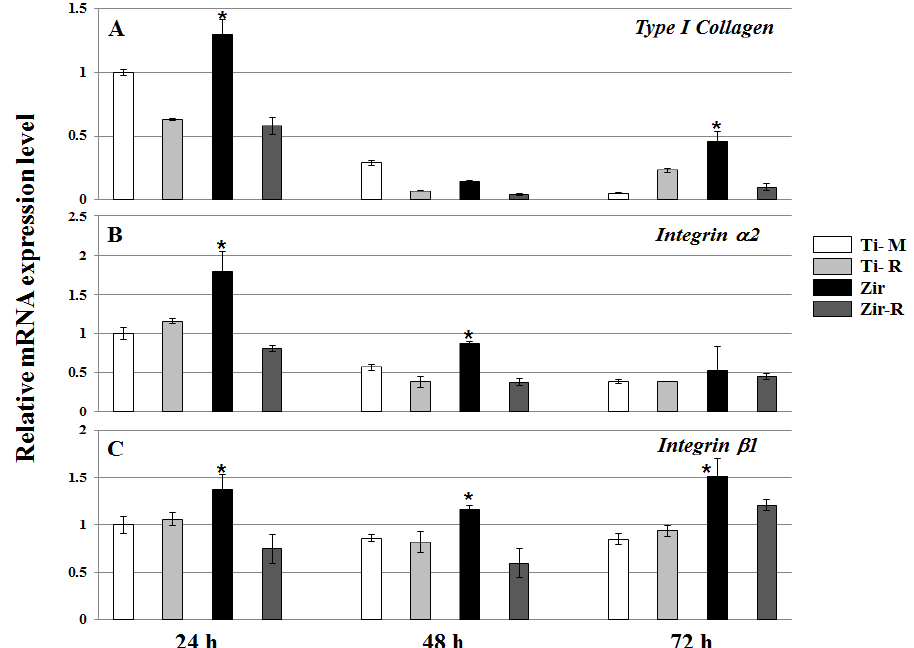
Figure 4. Real time polymerase chain reaction (RT-PCR) ( A ) Type I collagen, ( B ) Integrin α 2, and ( C ) Integrin β 1 in HGFs cultured on Ti- or Zir-discs after 24, 48 and 72